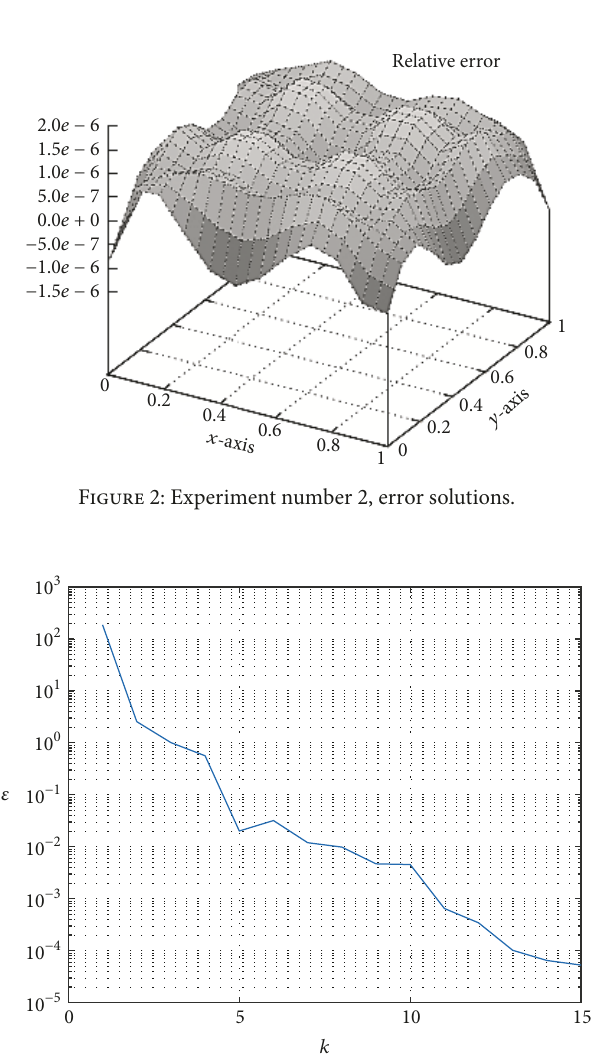
Initial values of weights of the RBFs were equal to zero. The solution error was equal to 5.3 ⋅ 10 −5 and was reached for 15 iterations. The error graph is shown in Figure